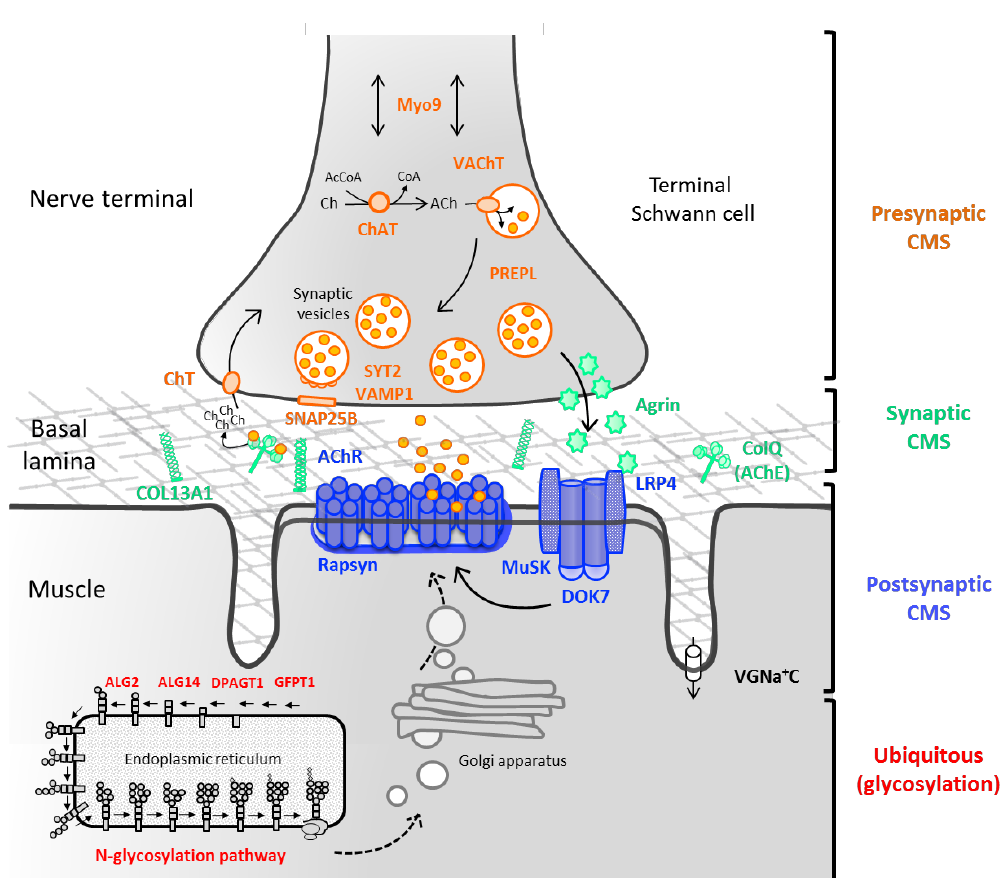
Figure 1. Schematic of the neuromuscular junction (NMJ) and the main molecules involved in congenital myasthenic syndromes. CMS result from presynaptic (ChAT, ChT, MUNC13-1, MYO9, PREPL, SYT2, VAChT, and VAMP1), synaptic basal lamina (COLQ and COL13A1), and postsynaptic defects (AChR subunits: α , β , δ and ε , AGRN, DOK7, MUSK, LRP4, and rapsyn). An increasing number of presynaptic CMS is being reported due to abnormalities in the synthesis, recycling or release of acetylcholine (normal arrows). The Agrin-LRP4-MuSK signaling pathway (bold arrows) is crucial for the clustering of the AChRs at the postsynaptic muscle membrane. Novel genes encoding for ubiquitous molecules (GFPT1, DPAGT1, ALG2, ALG14, and GMPPB) are represented in the endoplasmic reticulum (ER) in a simplified view of the N -glycosylation pathway. Post-translational modifications of the saccharide structure of the AChR and other NMJ proteins take place at the ER and Golgi apparatus (dashed arrows), before reaching the muscle cell surface as mature proteins. ACh, acetylcholine; AChE, acetylcholinesterase; AcCoA, acetyl coenzyme A; Ch, choline; VGNa + C, voltage-gated sodium channel.